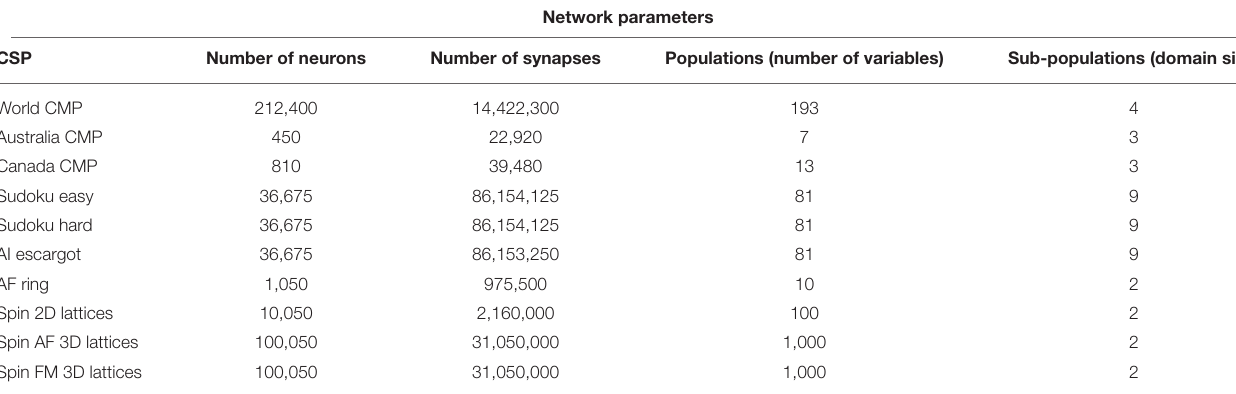
FIGURE 4 | Histograms of the convergence time to a solution for the Sudoku, map coloring and spin system problems of Figures 1 – 3 . For each histogram data from 100 simulations were used. The mean µ , standard deviation σ , skewness γ 1 , success ratio ξ and the best convergence time t min are indicated for each problem. The success ratio is defined as the number of times the simulation converged to satisfaction over the total number of simulations. TABLE 1 | Network sizes of the SNN solvers of the CMP, Sudoku, and Spin Systems. Network